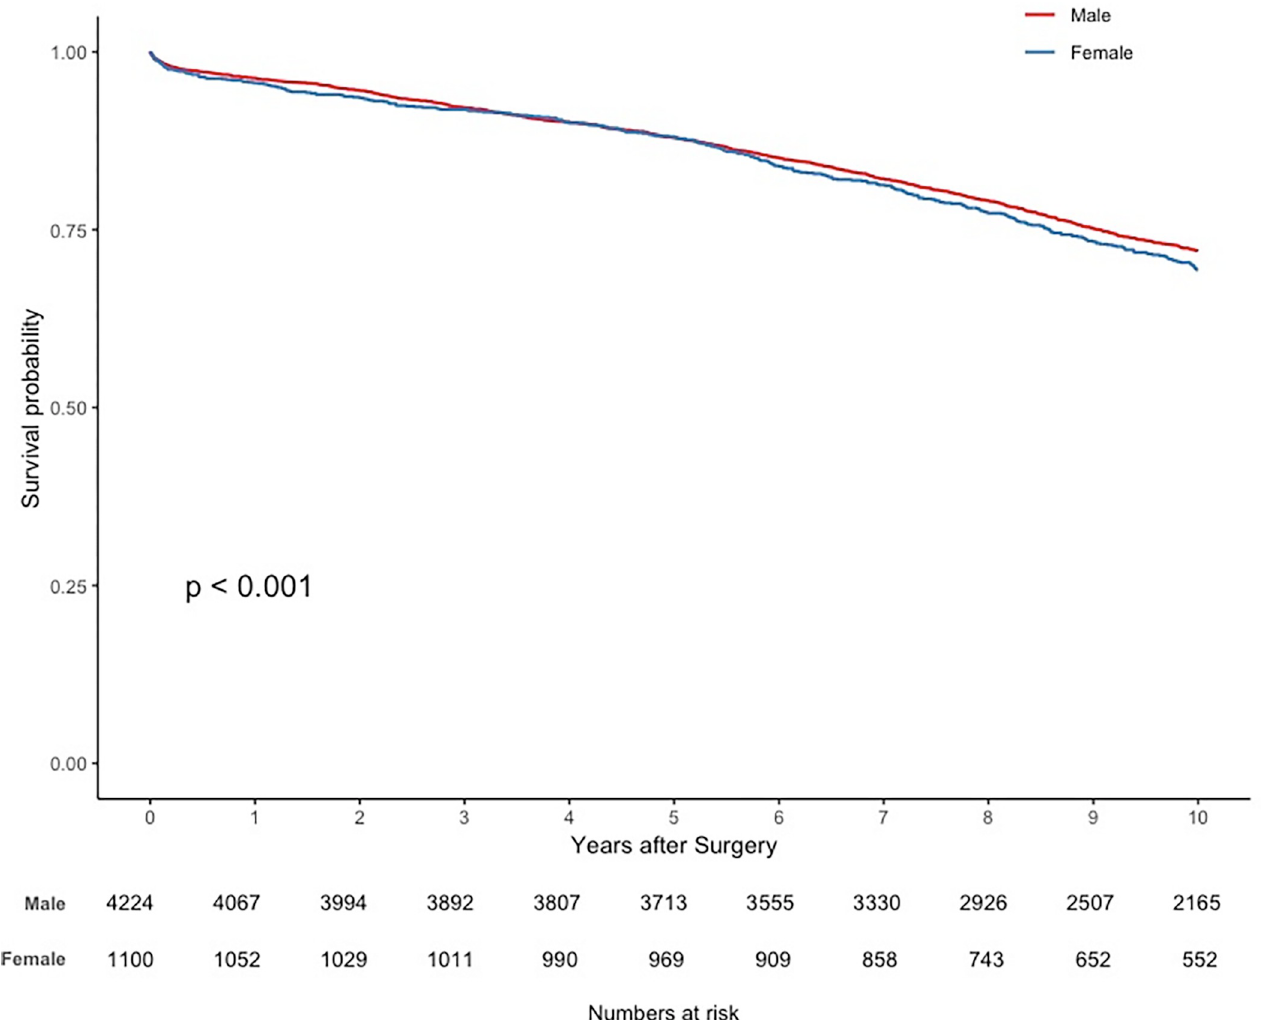
Fig 5. Unweighted survival function plot. Unadjusted survival function (Kaplan-Meier method): male vs female.